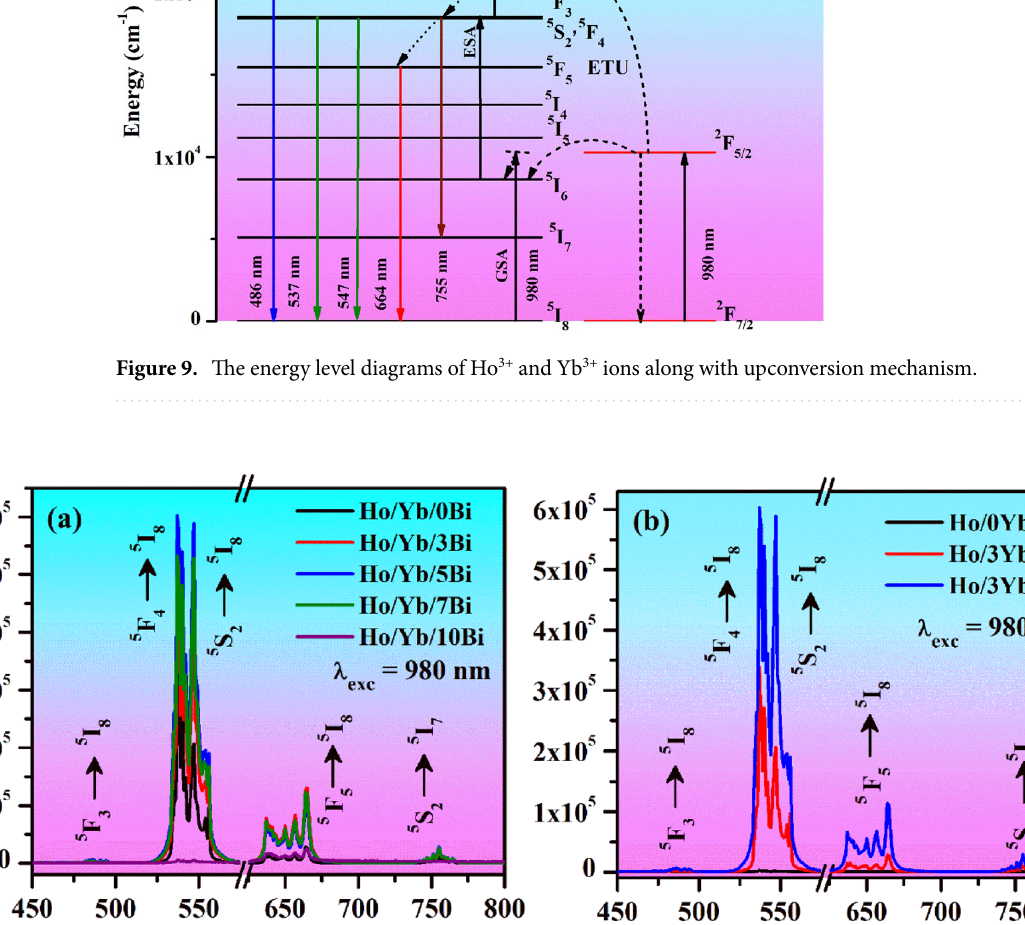
coactivated Ca 20 Al 26 Mg 3 Si 3 O 68 phosphor in which the concentration quenching also takes place at higher con- centrations of Bi 3+ ions. Our group has also studied the impact of Bi 3+ ion on the UC intensity of Er 3+ /Yb 3+ acti-